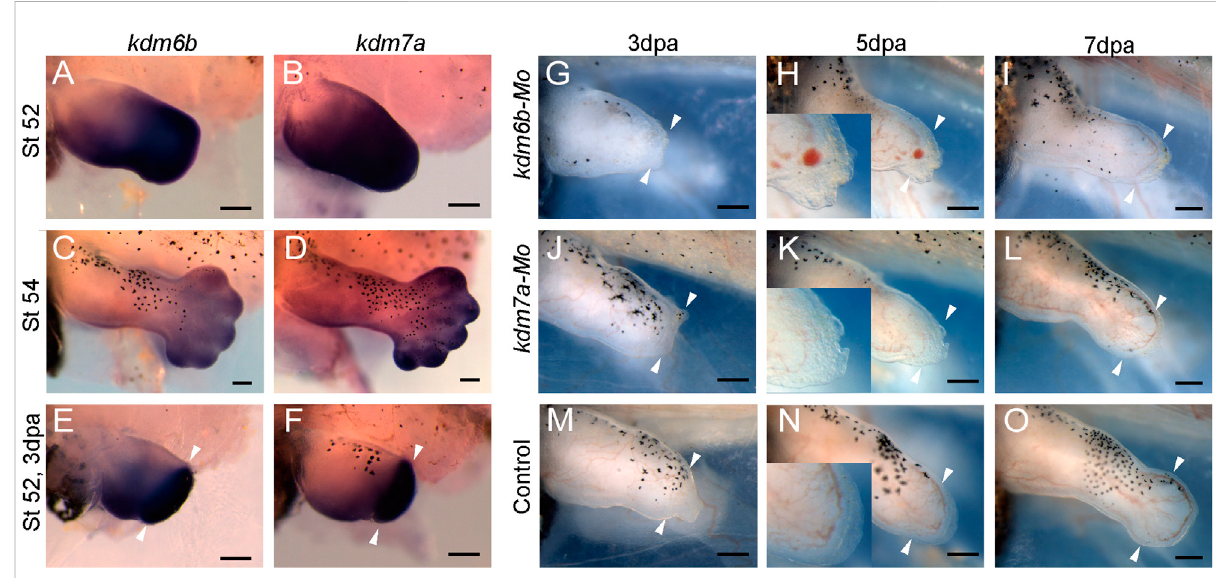
FIGURE 7 kdm6b and kdm7a in Xenopus tadpole hindlimb development and regeneration. (A – F) Expression of kdm6b (A,C,E) and kdm7a (B,D,F) in NF stage 52 (A,B) and stage 54 (C,D) Xenopus tadpole hindlimb, and 3 dpa limb regenerates (amputated at stage 52) (E,F) . (G – O) Representative images of tadpole hindlimbs at 3 dpa (G,J,M) , 5 dpa (H,K,N) , 7 dpa (I,L,O) after injection/electroporation of kdm6b Mo (G – I) , kdm7a Mo (J – L) or control Mo (M – O) . Images of tadpole limbs shown with dorsal up, anterior to the left. Scale bars represent 0.2